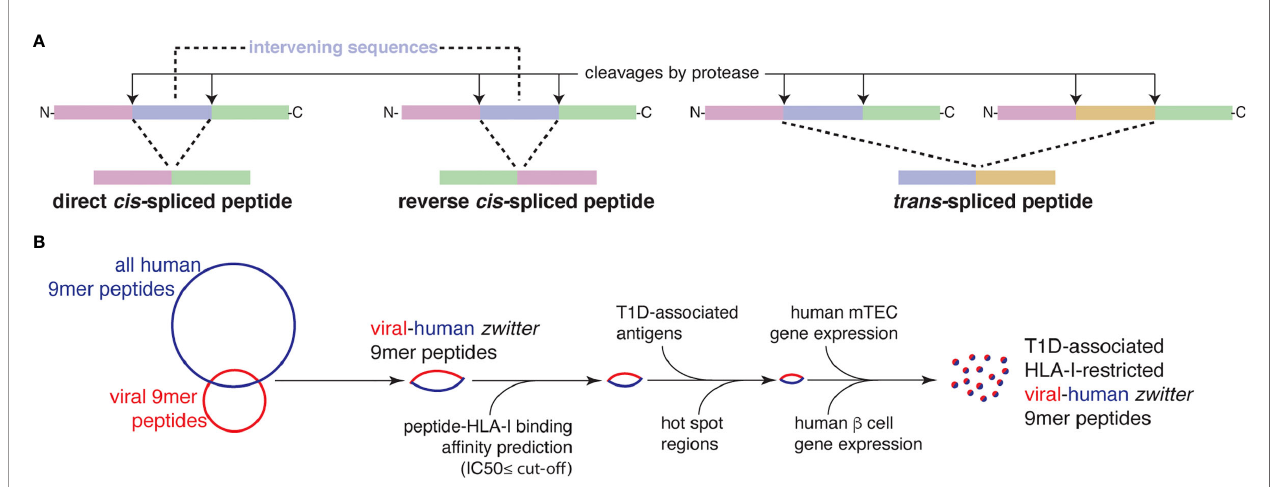
FIGURE 1 | Post-translationally spliced peptides and in silico pipeline for the identi fi cation of T1D-associated zwitter epitope candidates. (A) Post-translationally spliced peptides can be formed by: i cis- peptide splicing, when the two splice-reactants, i.e . the non-contiguous peptide fragments ligated by a protease, derive from the same polypeptide molecule; the ligation can occur in normal order, i.e. following the orientation from N- to C-terminus of the parental protein (direct cis - spliced peptides), or in the reverse order (reverse cis -spliced peptides); ii. trans -peptide splicing, when the two splice-reactants originate from two distinct protein molecules or two distinct proteins (6). (B) In silico pipeline to identify a pool of zwitter non-spliced or cis -spliced epitope candidates associated with